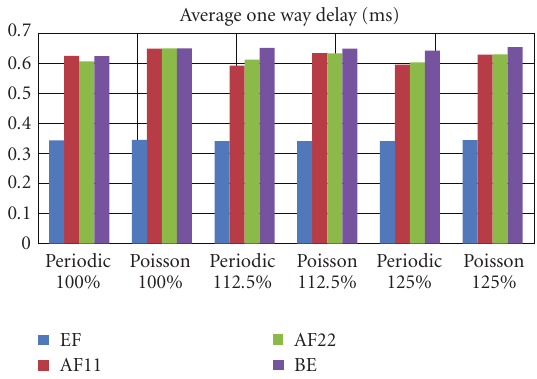
Figure 10: Average one way Delay